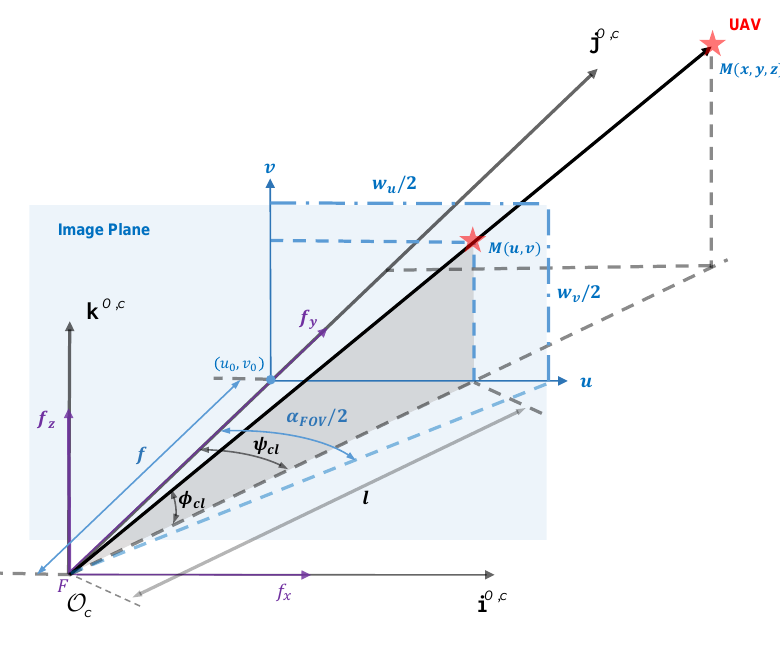
Figure 5. The geometry of one PTUwith respect to the optical center and the image